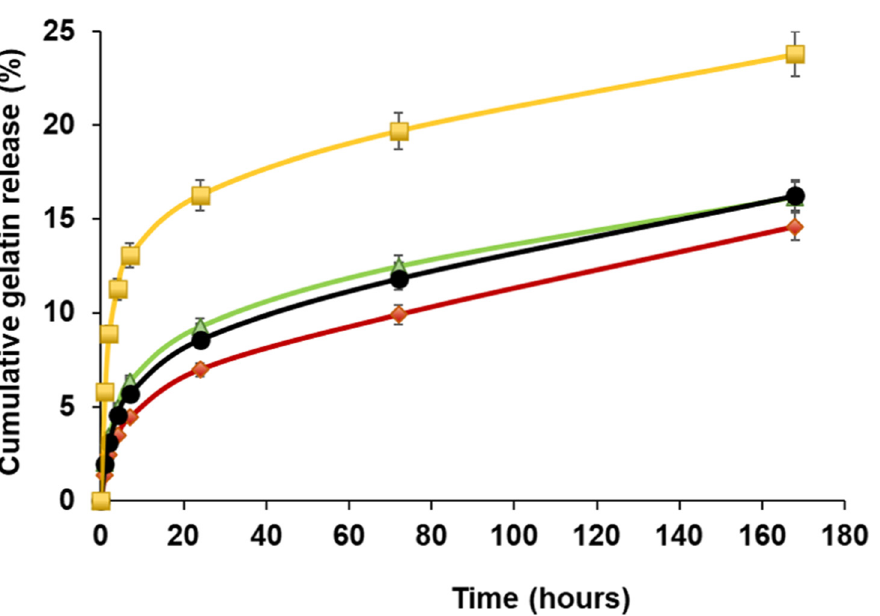
Figure 4. Gelatin cumulative release from 3070DKMonoGelCTC (yellow), 3070DKDoubleGelCTC (green), 3070MonoGel (black) and 3070DoubleGel (red). Each analysis was carried out in triplicate.